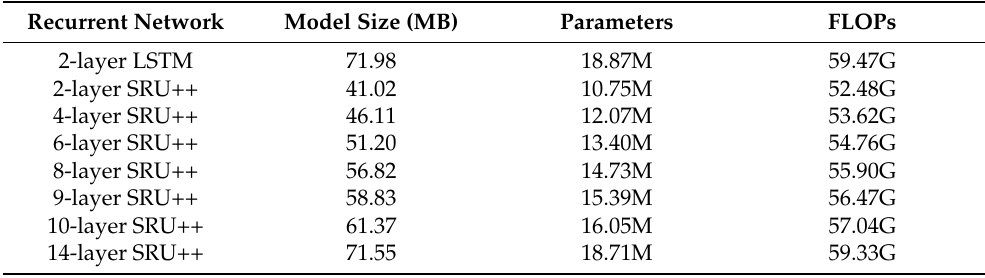
Table A3. Model size, parameters, and FLOPs of VibDenoiser with different recurrent layers.